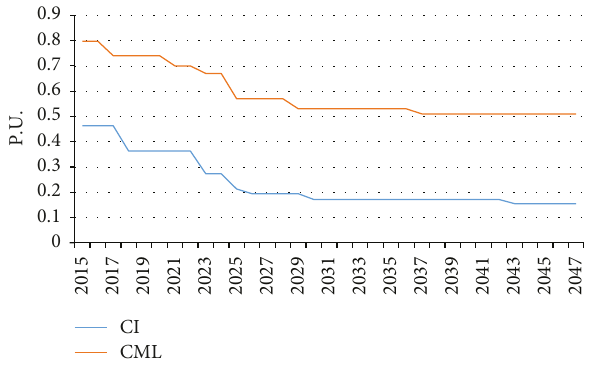
Figure 20: CML and CI; DECC2, 2015 –